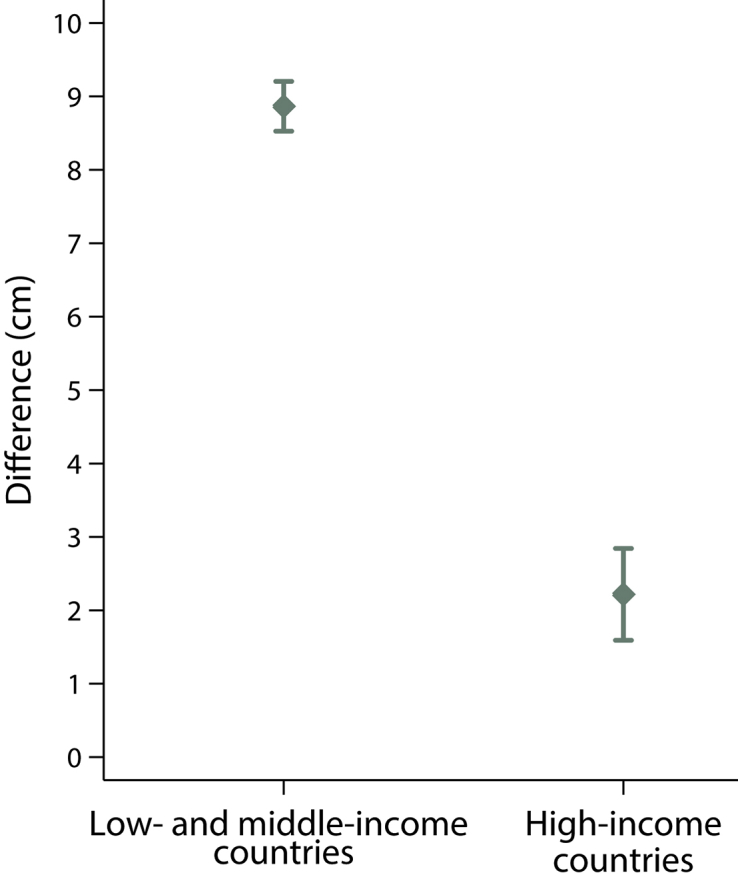
Expected increase from parental heightMean (95% confidence interval) difference between estimated adult height (calculated by doubling infant length at 2 years of age) and mean parental height (calculated as the average of maternal and paternal heights) for children who were included in the INTERGROWTH-21st Fetal Growth Standards21 for study sites located in low- and middle-income countries and high-income countries.Villar et al. Validation of the INTERGROWTH-21st fetal growth standards. Am J Obstet Gynecol 2018.